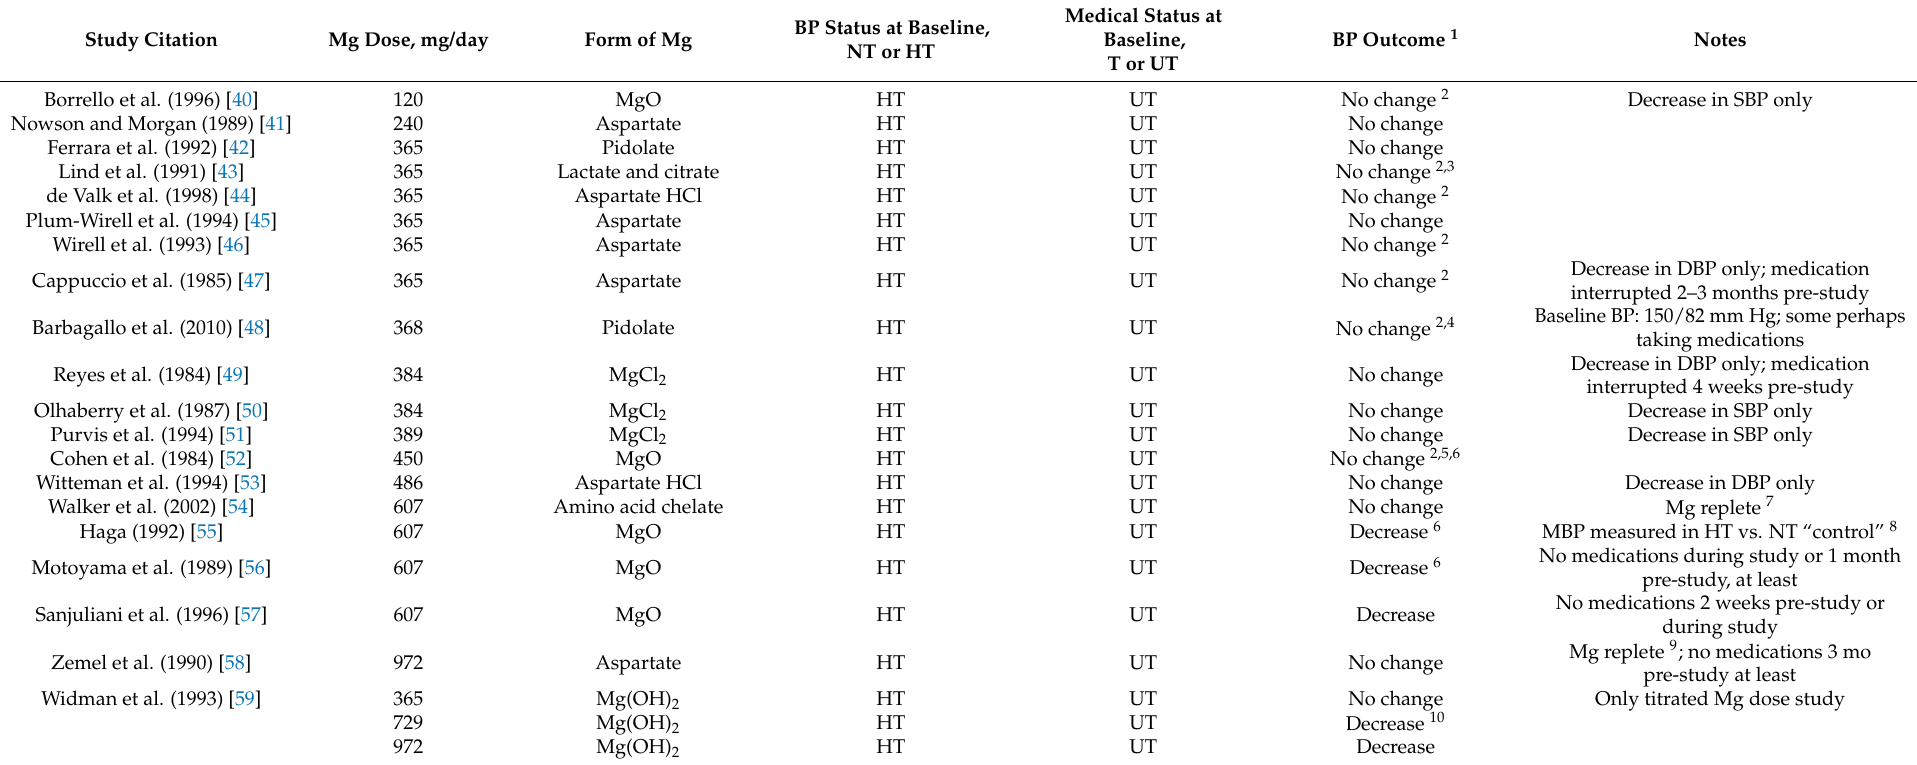
Table 1. Summary of magnesium supplementation studies for blood pressure in Untreated Hypertensives (subjects untreated with antihypertensive medications, hypertensive at